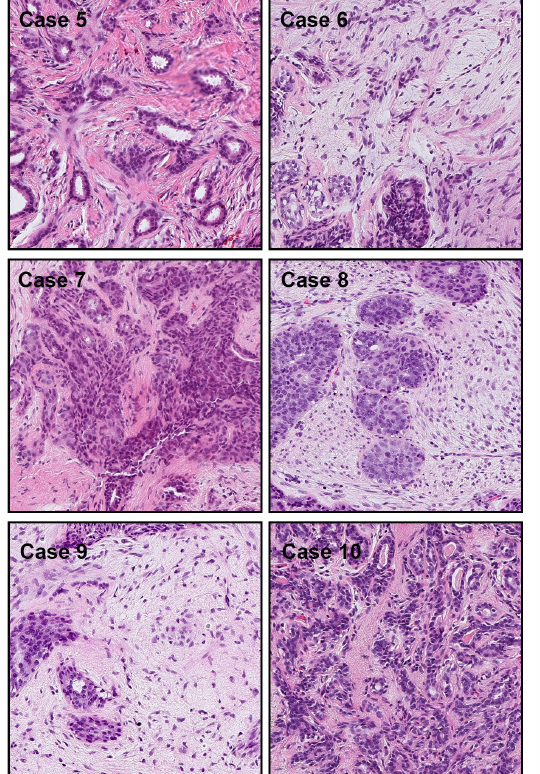
Figure 8. Representative tissue areas (Cases 1–10), without heatmap overlay, that were falsely predicted as IDC. There were 10 cases of false positive prediction outputs from the core needle biopsy test set. The false positive predictions are most likely due to the enlarged spindle shaped stromal cell nuclei with pleomorphism and tubules composed of cuboidal or low columnar cells with round uniform nuclei resting on a myoepithelial cell layer. This is morphologically analogous to invading single cells, ductular structures, and cancer stroma in